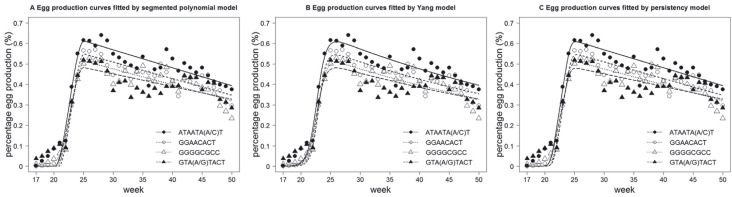
Average weekly egg production rates and the fitted egg production curves
for different LY haplotypes. ATAATA(A/C)T represented two haplotypes (ATAATAAT
and ATAATACT), as did GTA(A/G)TACT.